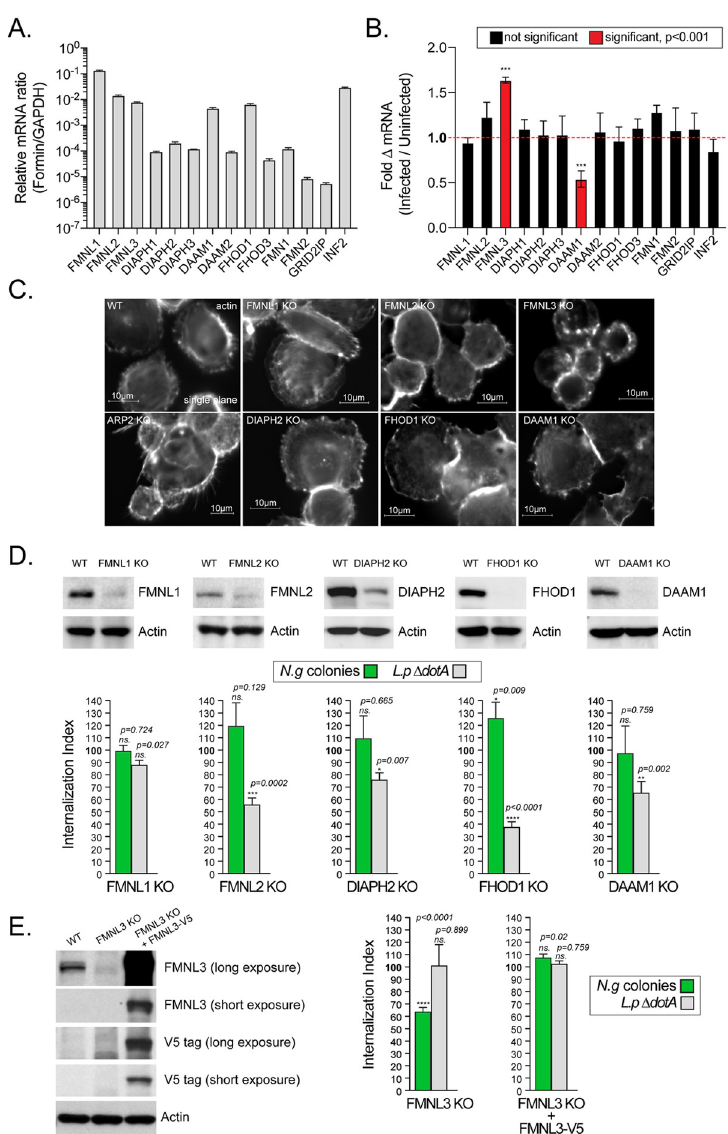
Fig 8. FMNL3 mediates invasion of gonococcal colonies in macrophages. (A-B) qPCR mRNA expression analyses for the members of the formin family in U937 MFs are shown. mRNA abundance relative to gapdh mRNA is shown in (A) . Fold change in mRNAs abundance upon N . g FA1090 infection of U937 MFs at 4 hpi is shown in (B). (A-B) Means of three biological replicates ± SD are shown, ��� p < 0.001 unpaired T-test (C) Representative single plane micrographs of differentiated resting U937 MFs cell lines stained with phalloidin. (D and E) Analysis of gonococcal colony internalization, phagocytosis and immunoblot validation of U937 MFs cell lines lacking different formins. (D and E) The Internalization index for each condition was calculated by dividing the percentage of internalized objects from infections of the knock out U937 MFs cell line by the percentage of internalized objects from infections of the parental U937 MFs, which was then multiplied by 100. Values > 100% indicate increased object internalization by the KO cell line compared to WT cells, whereas values < 100% indicate decreased object internalization by the KO cell line. At least 100 objects for each condition were scored. Means from three biological replicates ± SD. The statistical significance of the differences between the internalization index from the KO cells and the parental cells for each condition were calculated using the unpaired T-test, not significant (ns.). (D and E) Immunoblot validation for loss of protein expression in U937 MFs differentiated from several KO cell lines in which different formin genes were inactivated. Complementation of the FMNL3 KO U937 MFs with V5-tagged FMNL3 is shown in (E) .